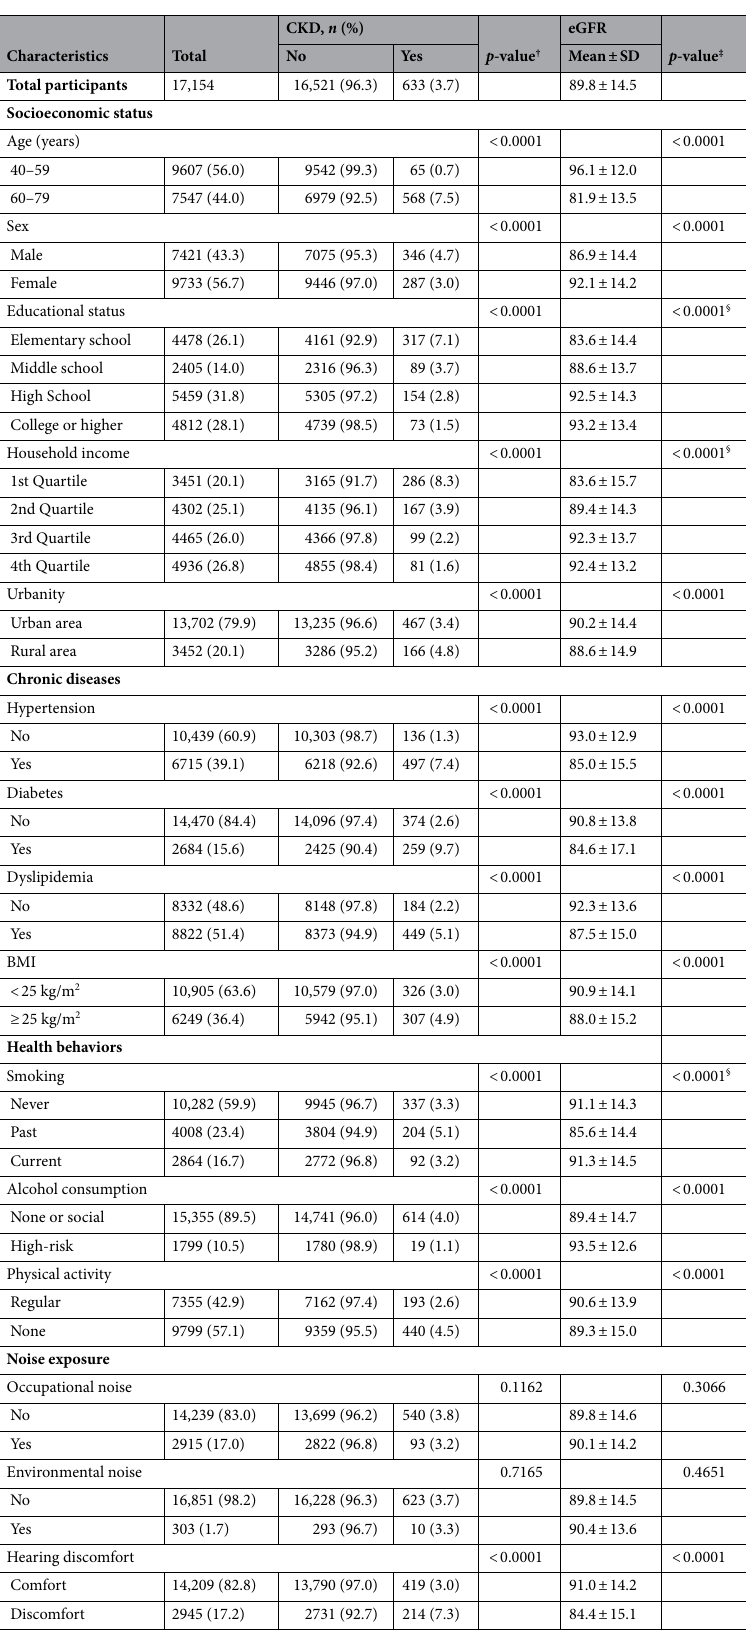
Table 1. Characteristics of study participants according to the kidney function status. CKD chronic kidney disease, SD standard deviation, eGFR glomerular filtration rate, BMI body mass index. † Chi-squared